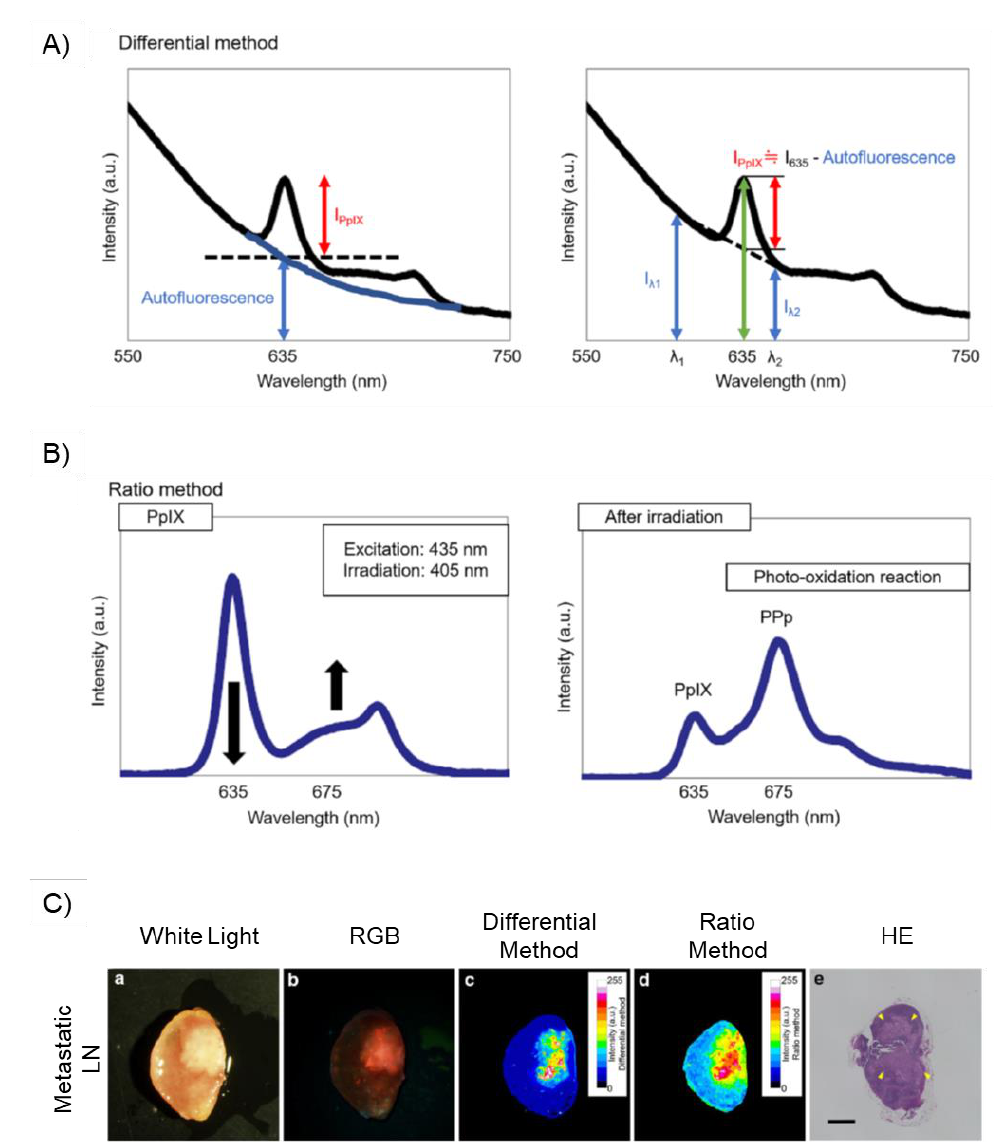
Figure 5. Elimination of background tissue autofluorescence by using the differential method and the ratio method for specific detection of protoporphyrin IX (PpIX)